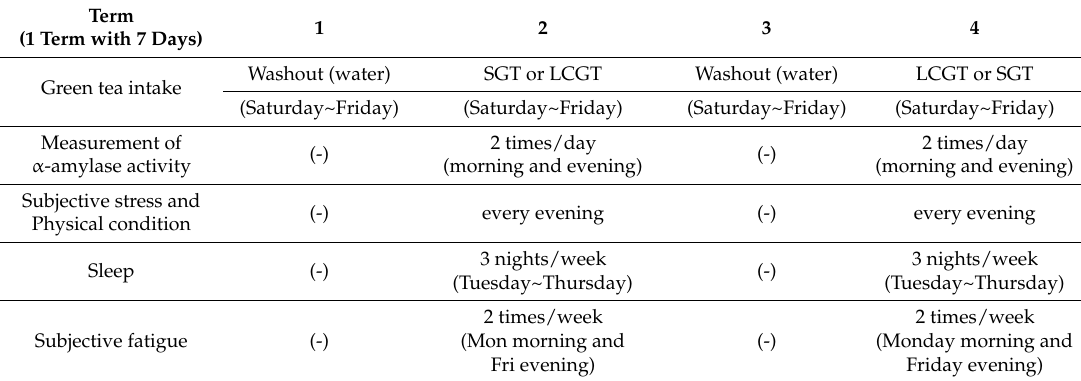
Table 1. Experimental